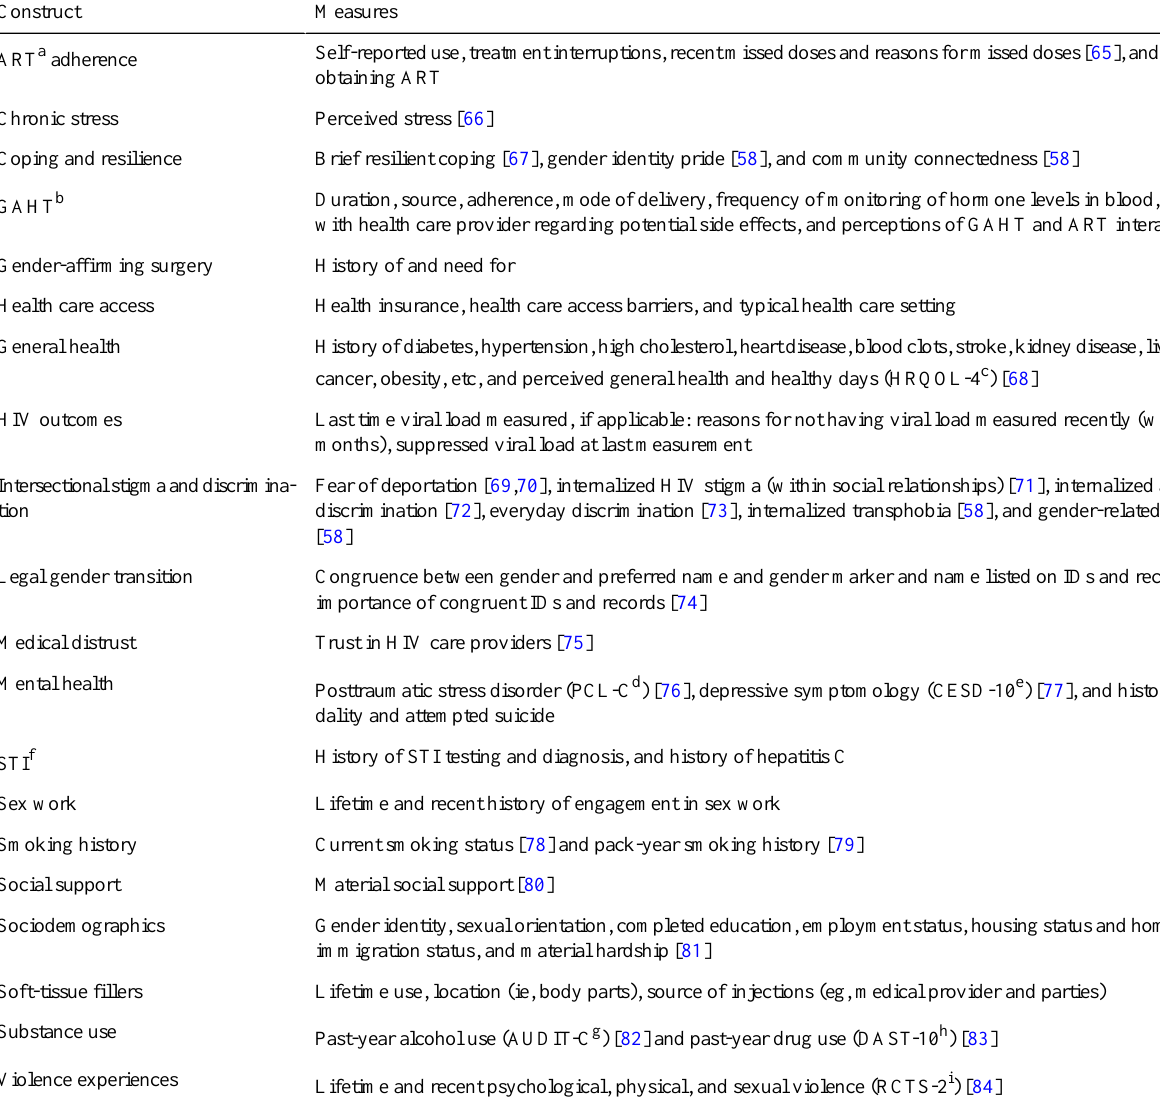
Table 1. Key quantitative measures of the baseline survey.